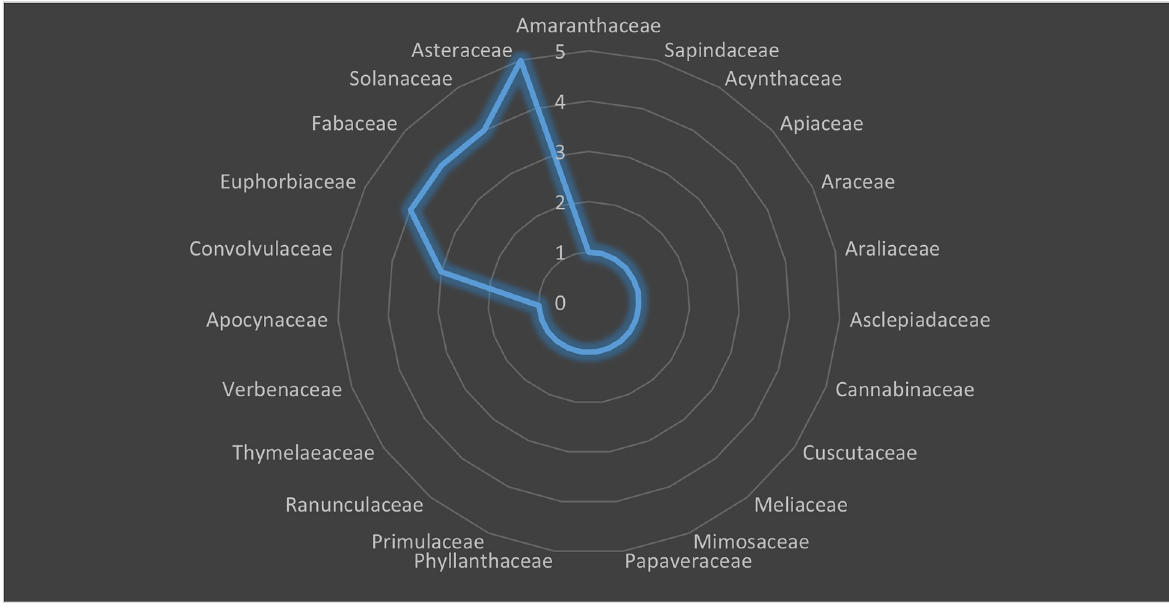
Fig 3. Distribution of poisonous plants in different families.